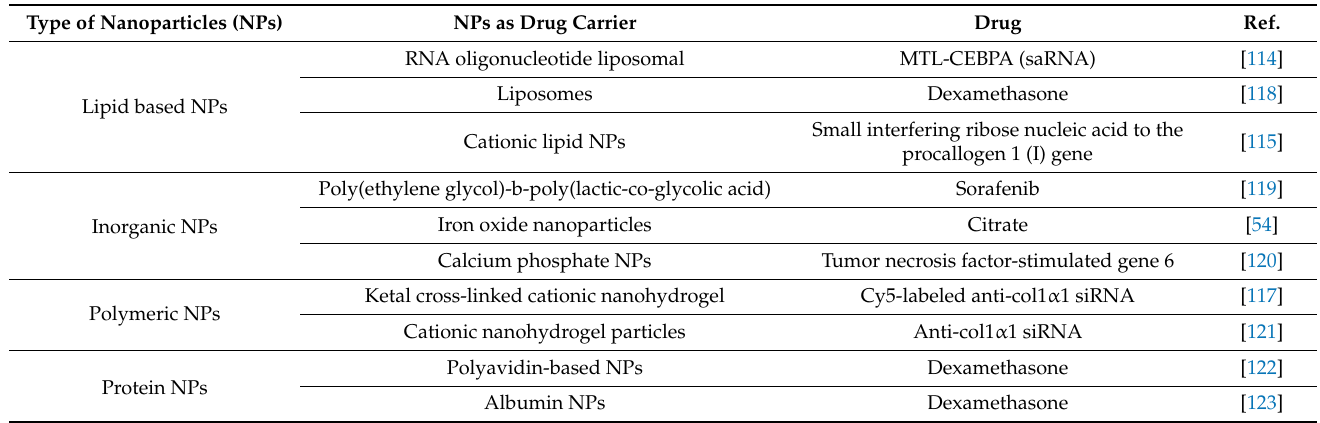
Table 2. Perspectives of applications of nanoparticles as synthetic drug delivery carrier for liver fibrosis